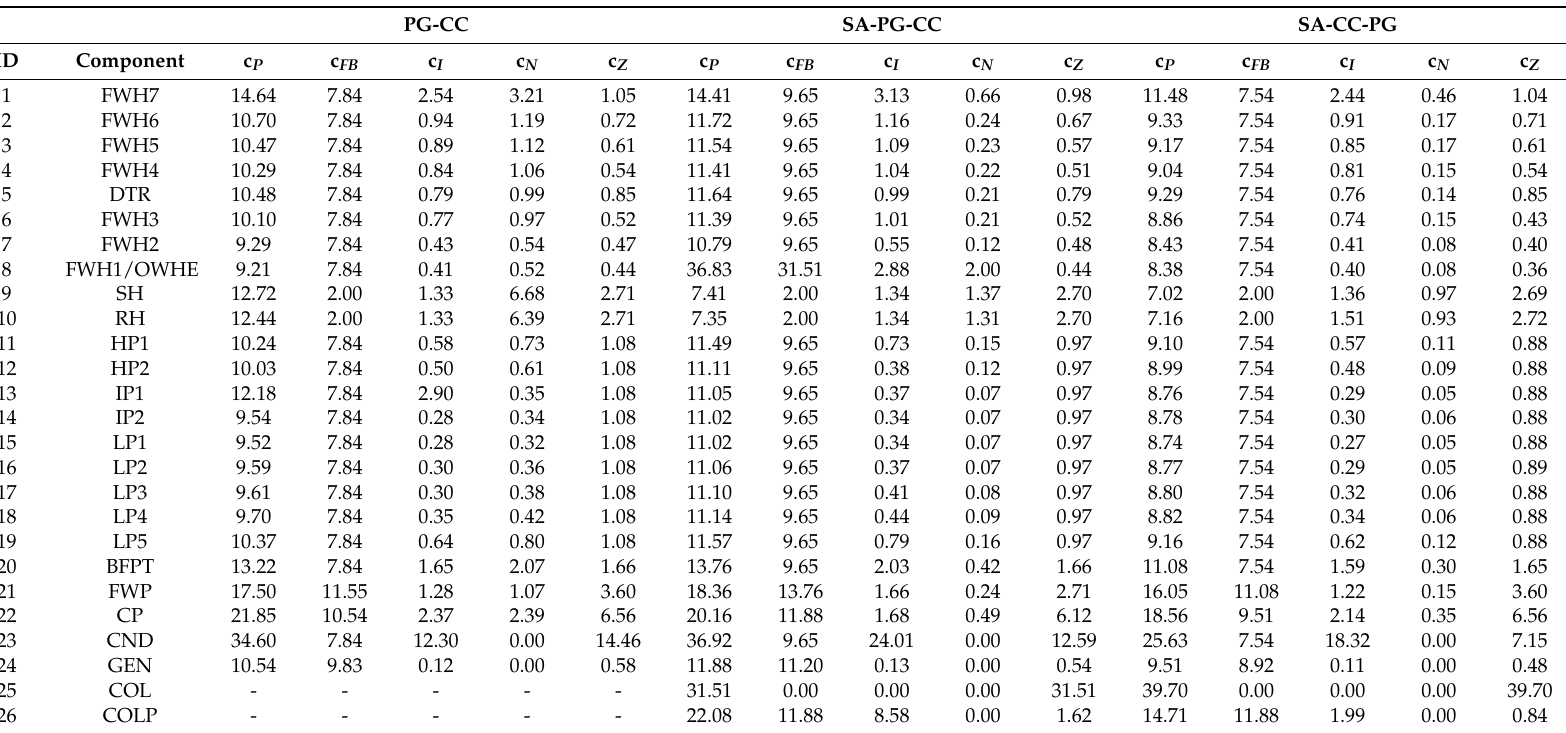
Table A5. Results of Thermo-Economic Cost ($/kJ) in the PG-CC, SA-PG-CC and SA-CC-PG